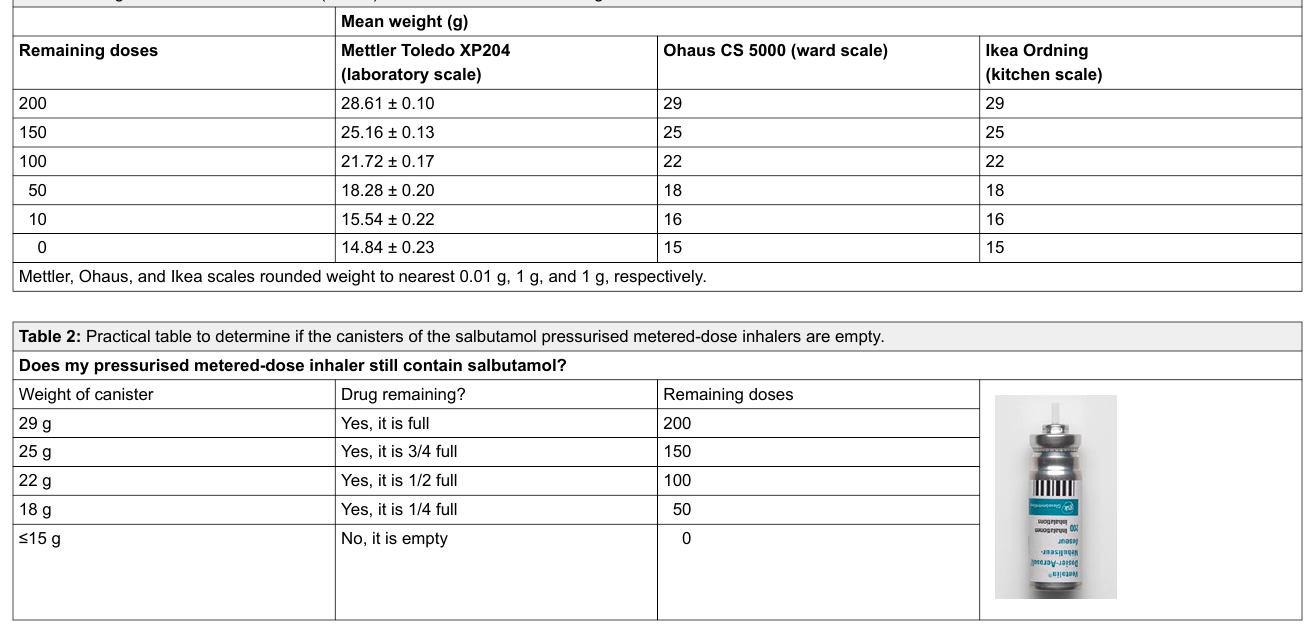
Table 1: Weight of salbutamol canisters (n = 60) in relation to doses remaining across three different scales. Remaining doses Mettler Toledo XP204